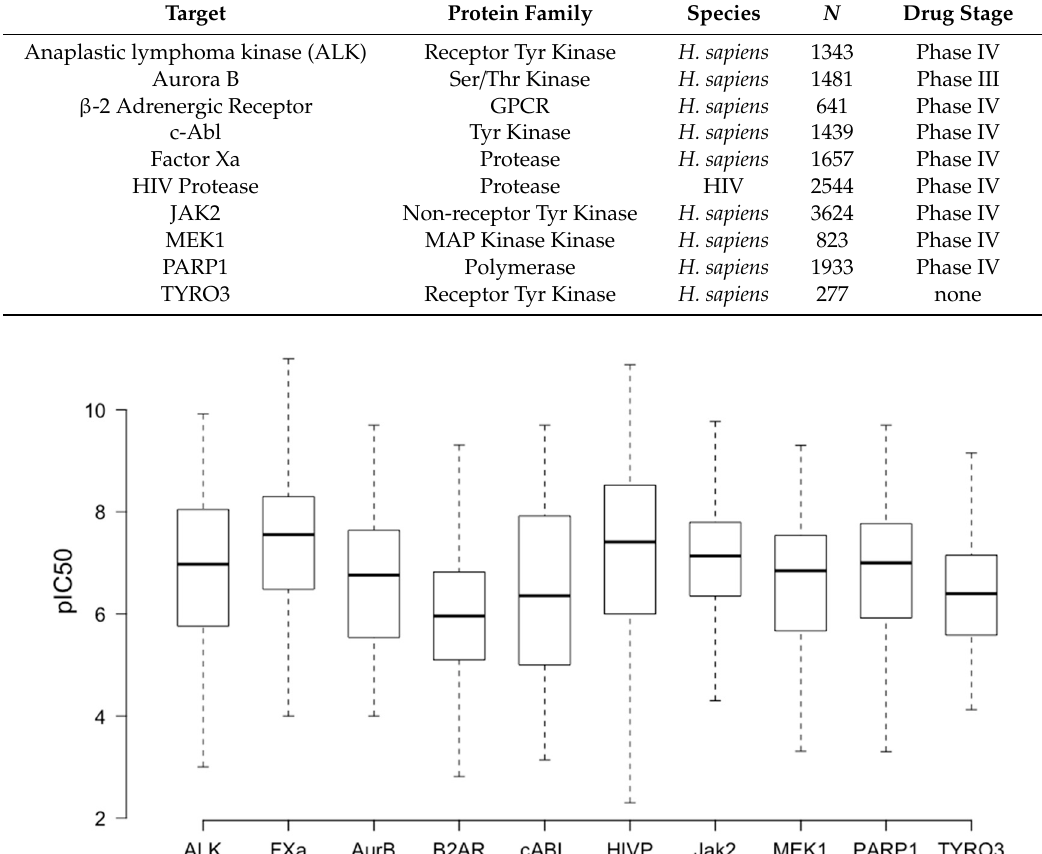
Table 1. Summary of the ten targets investigated.